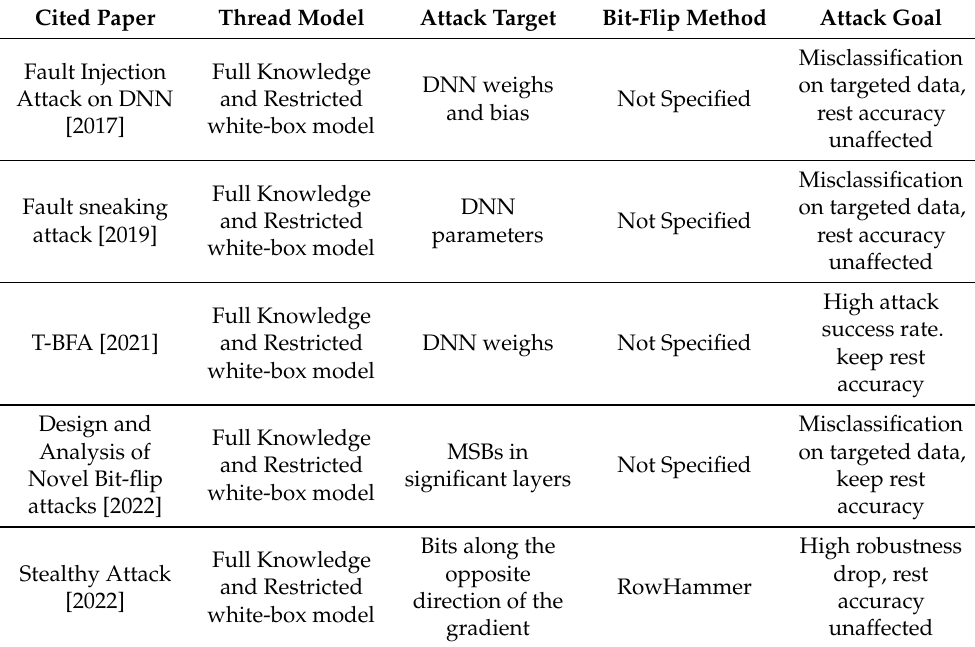
Table 3. The detailed attack aspects for targeted bit-flip